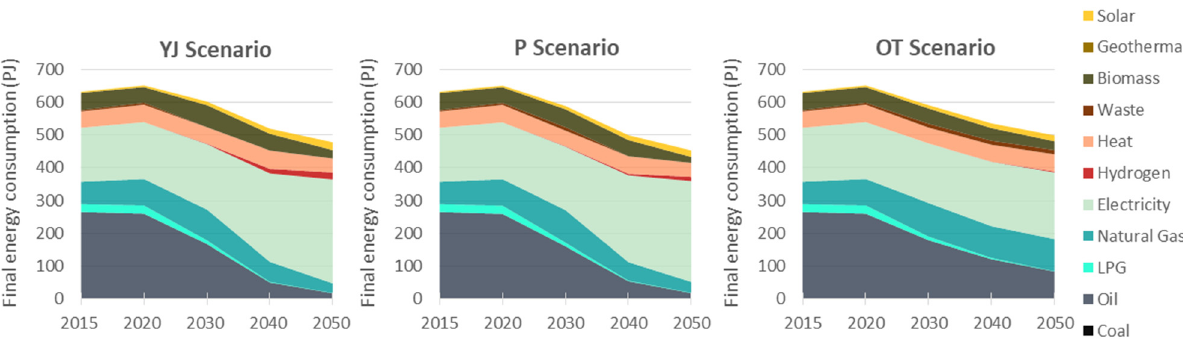
Figure 6. Final energy consumption (PJ) by fuel and scenario: Yellow Jersey (YJ), Pack (P), and Off Track (OT).